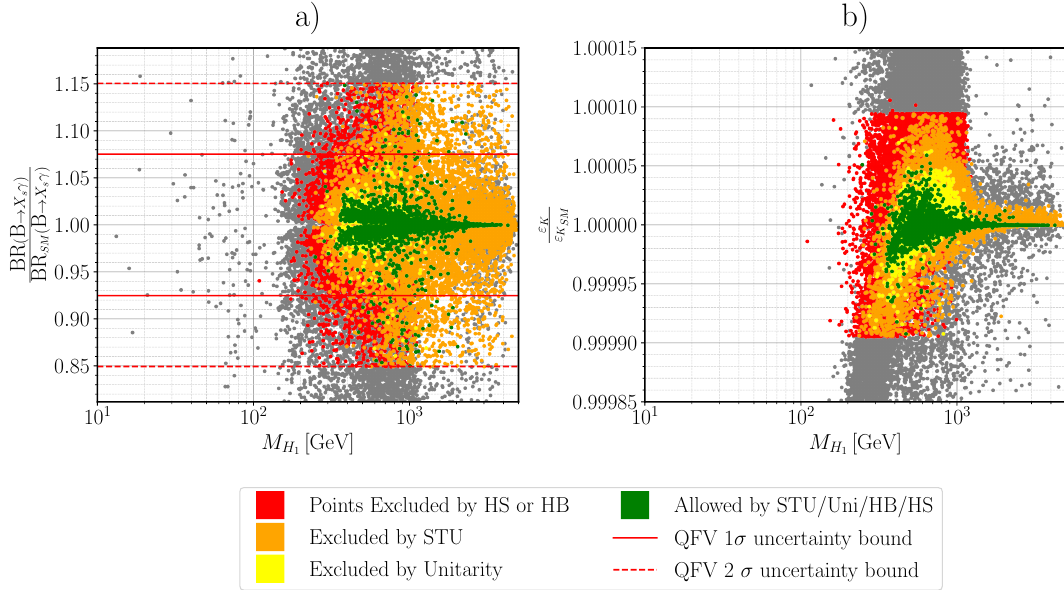
Figure 3 . Scatter plots of parameter space allowed by several constraints imposed on the BGL-like 3HDM. In the left panel, (a), we show the results for b → sγ , namely, the ratio of 3HDM-to-SM branching fractions for B → X reaction while in the right panel, (b), we plot an analogous ratio s γ for (cid:15) , both in terms of the H mass. The colour code is as in figure 2 and grey points are excluded, K 1 at 2 σ level, by at least one QFV